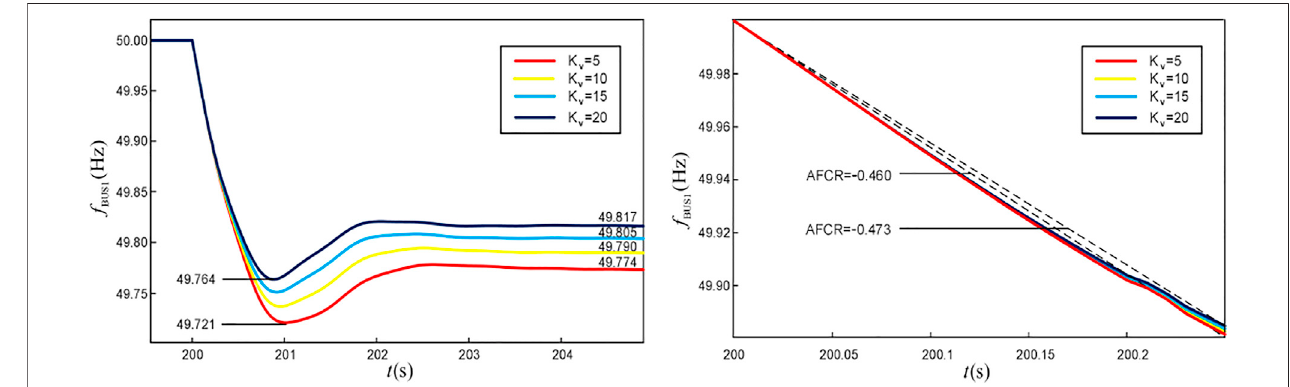
FIGURE 17 | Frequency response of the system for different K v .